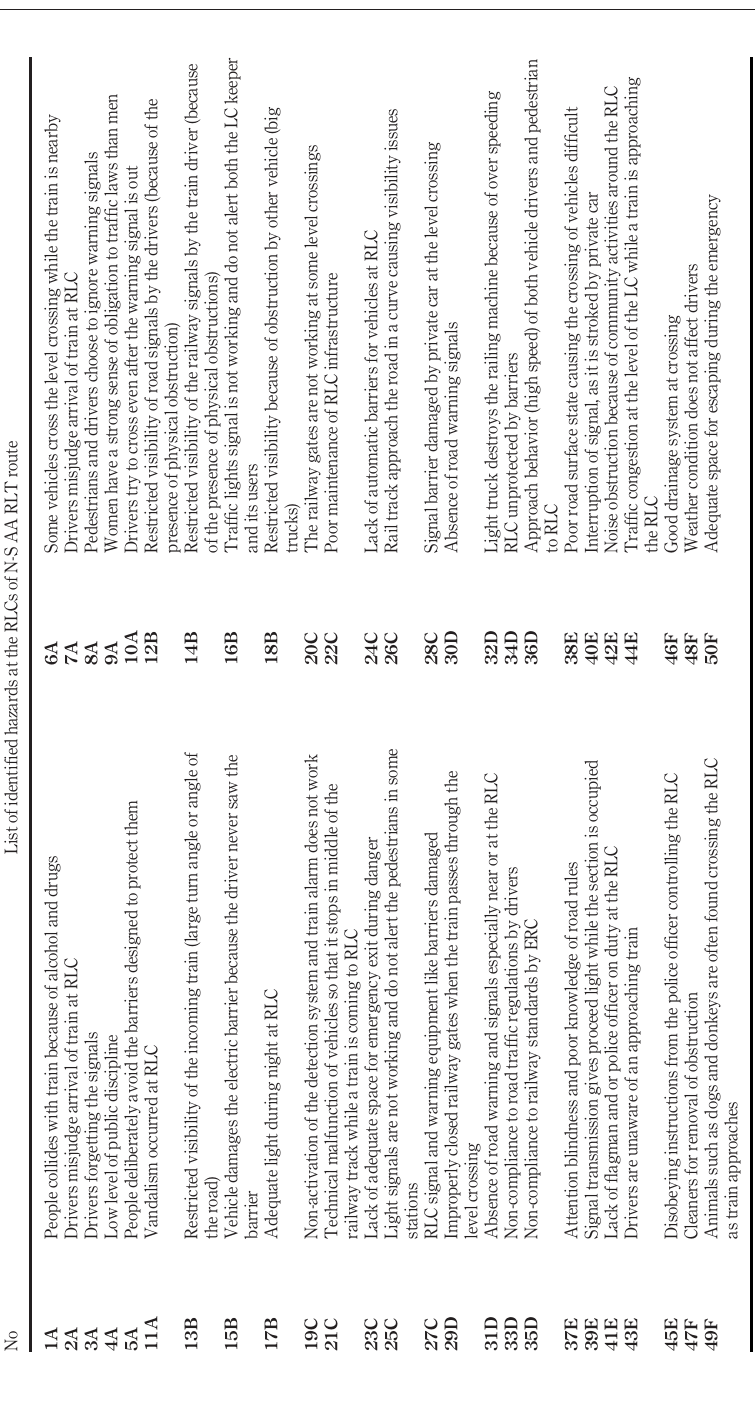
Table 1. List of identified hazards at the RLCs of N-S AA RLT